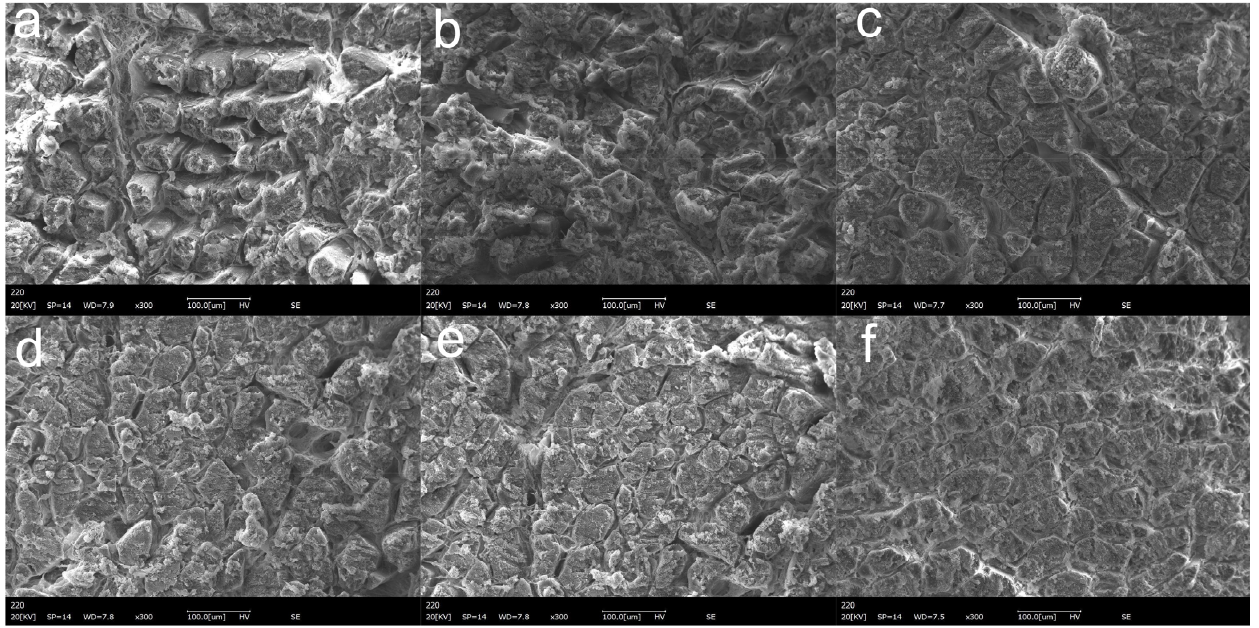
Figure 5. Microstructural changes of different treatment conditions. (magnification 300×). ( a ) 3% NaCl; ( b ) 3% NaCl and 1% glycerol; ( c ) 3% NaCl and 4% glycerol; ( d ) 3% NaCl with UT; ( e ) 3% NaCl and 1% glycerol with UT. ( f ): 3% NaCl and 4% glycerol with UT.